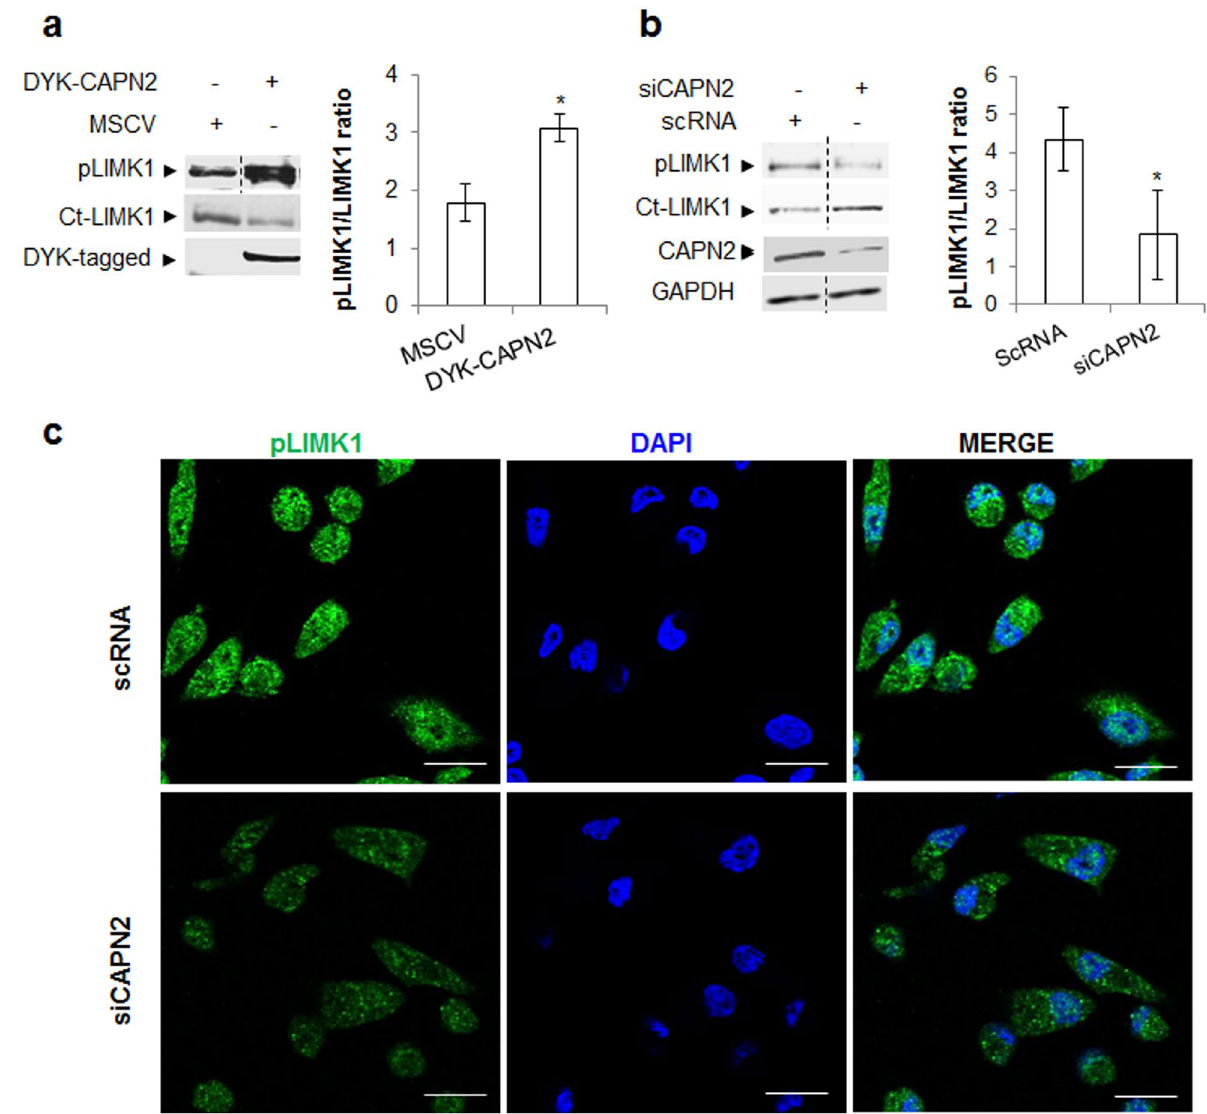
Figure 5. CAPN2 promotes phosphorylation of LIMK1 in BCCs. ( a ) p(Thr508)LIMK1 and total Ct-LIMK1 levels analyzed by western blot in MCF-7 cells transfected with MSCV empty vector or DYK-CAPN2. Anti-DYK antibody was used to assess transfection efficiency. Data (n ≥ 3) were quantified and plotted as mean pLIMK1/ LIMK1 ratio ± SEM. *p ≤ 0.05 vs. MSCV. ( b ) p(Thr508)LIMK1 and total Ct-LIMK1 levels in MDA-MB-231 cells transfected with scRNA/siCAPN2. Anti-CAPN2 and anti-GAPDH antibodies were used to assess transfection efficiency and equal loading respectively. Data (n ≥ 3) were quantified, and plotted as mean pLIMK1/LIMK1 ratio ± SEM. *p ≤ 0.05 vs. scRNA transfected-cells. ( c ) p(Thr508)LIMK1 (green) distribution in MDA-MB-231 cells transfected with scRNA/siCAPN2 (n = 3) was analyzed by immunofluorescence staining. Nuclei stained with DAPI (blue) and merge images are shown. Scale bars 20 μm. Juxtaposed images from different lanes in the same blot are separated by dotted lines in ( a , b ). Full-length blots are presented in Supplementary Fig.